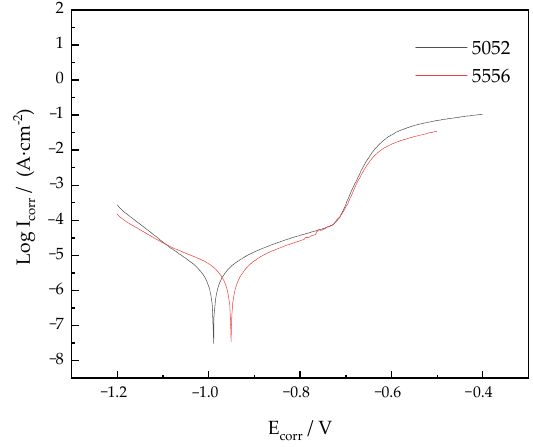
Figure 15. Polarization curves of Al-Mg alloys.